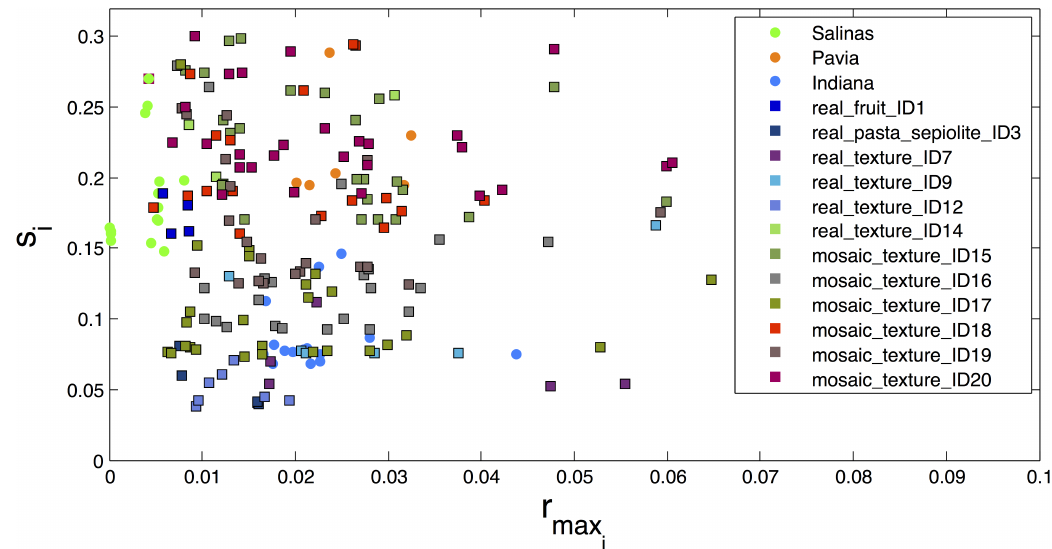
Figure 18. Averaged inter-class distance ( y -axis) between each class and the rest of the classes vs. averaged intra-class distance ( x -axis) of each class in terms of normalized spectral angle between 0 and 1 for the Pavia, Indiana, and Salinas scenes and selected images from the GII-HSEG